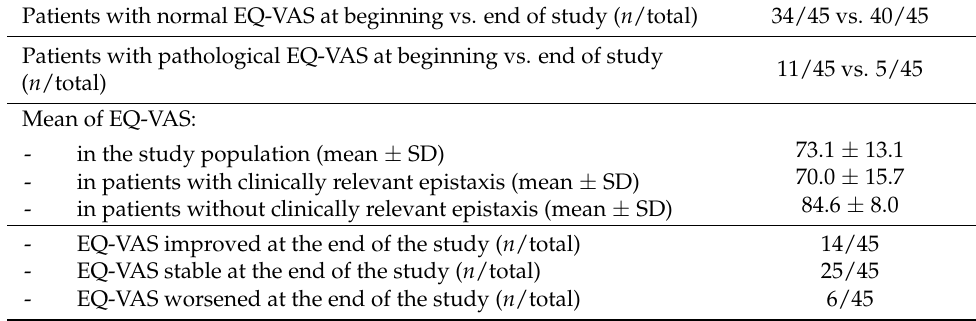
Table 4. EQ-VAS values during the study. Patients with normal EQ-VAS at beginning vs. end of study ( n /total) Patients with pathological EQ-VAS at beginning vs. end of